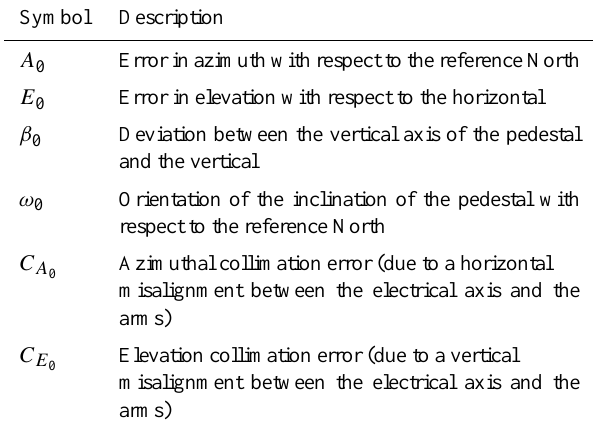
Table 1. Radar positioning errors (in